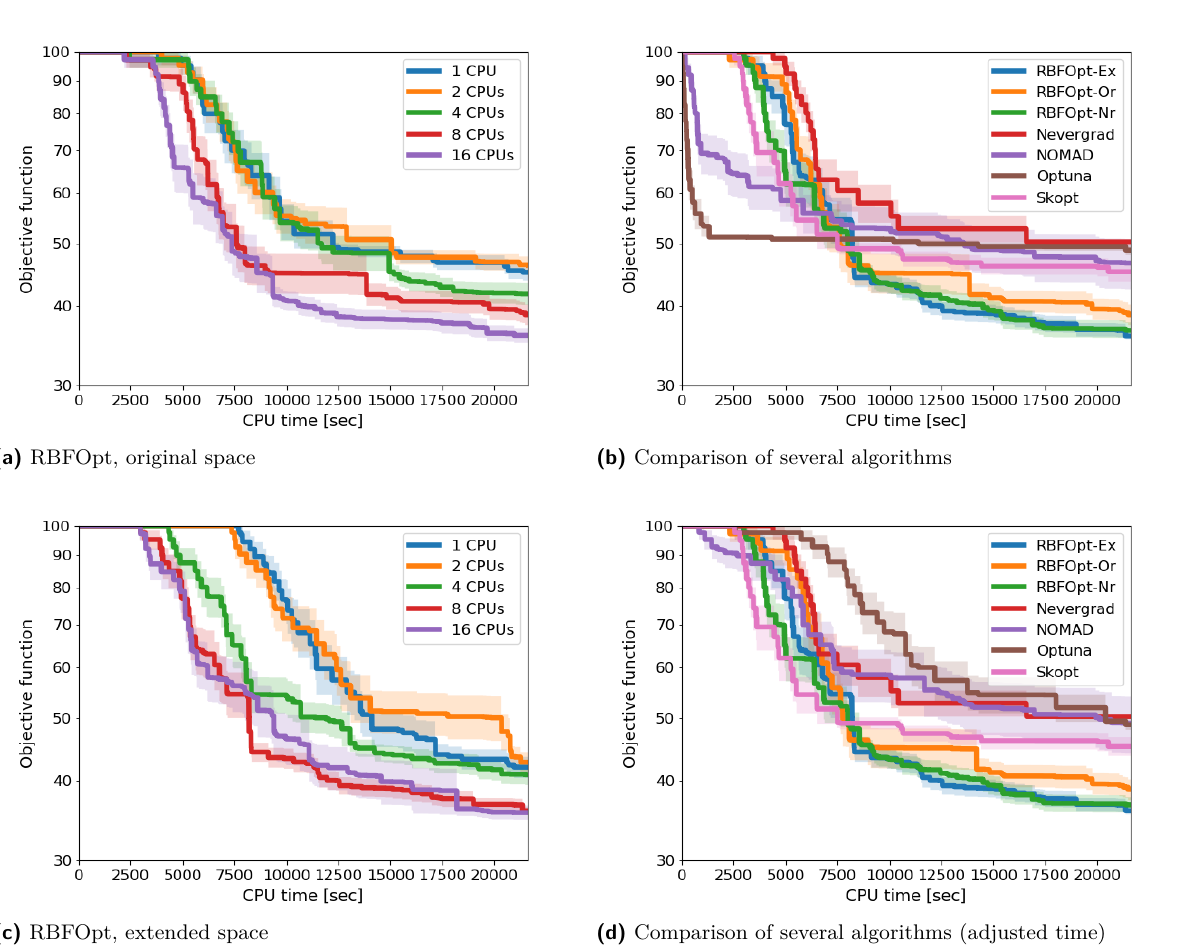
Figure 7 Average objective function value over wall-clock time, for the optimization of the hyperpa- rameters of a random forest classifier. The shaded regions represent the area containing the average plus/minus the standard error. In subfigure 7b, the “RBFOpt-Or” and “RBFOpt-Ex” curves use the default settings of the algorithm in original and extended space, respectively; the “RBFOpt-Nr” version is like “Extended” but skips the Refinement step. In subfigure 7d, we adjust the plots so that all algorithms report time in a similar way, see discussion in the main text. Subfigures 7b and 7d use 8